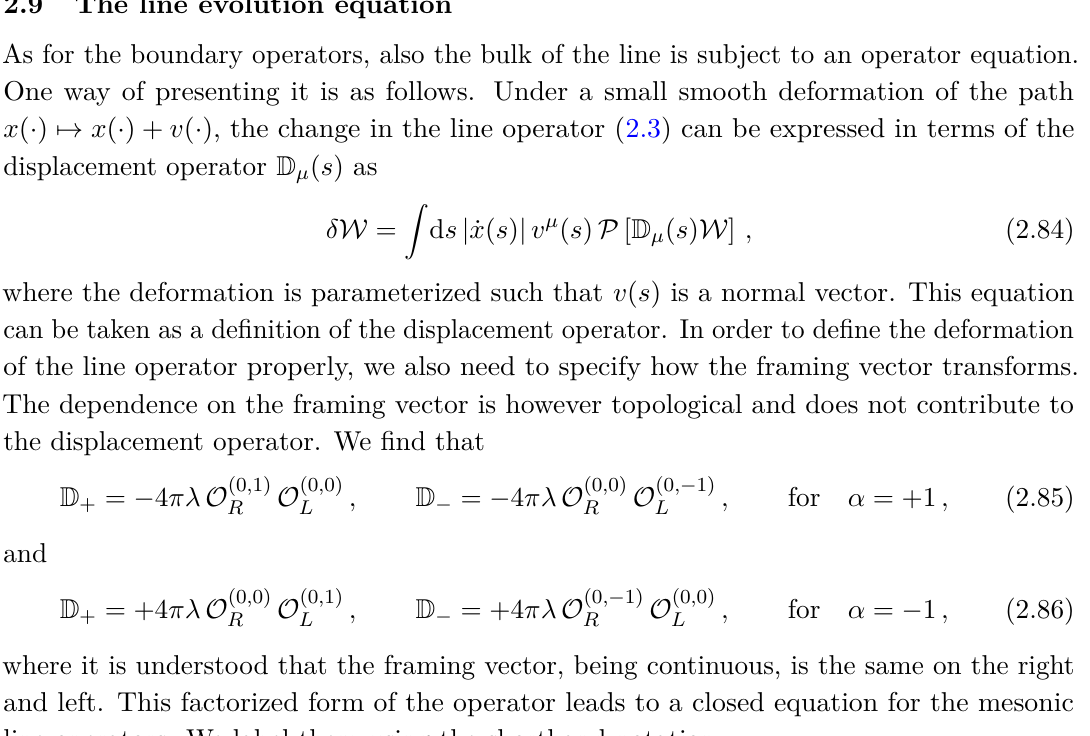
Figure 7 . The three diagrams that contribute to the vertex V understood to act on O (0 , − s ) The blue line and the filled blue blob are the same as in figure 5, and represent the effective vertex function